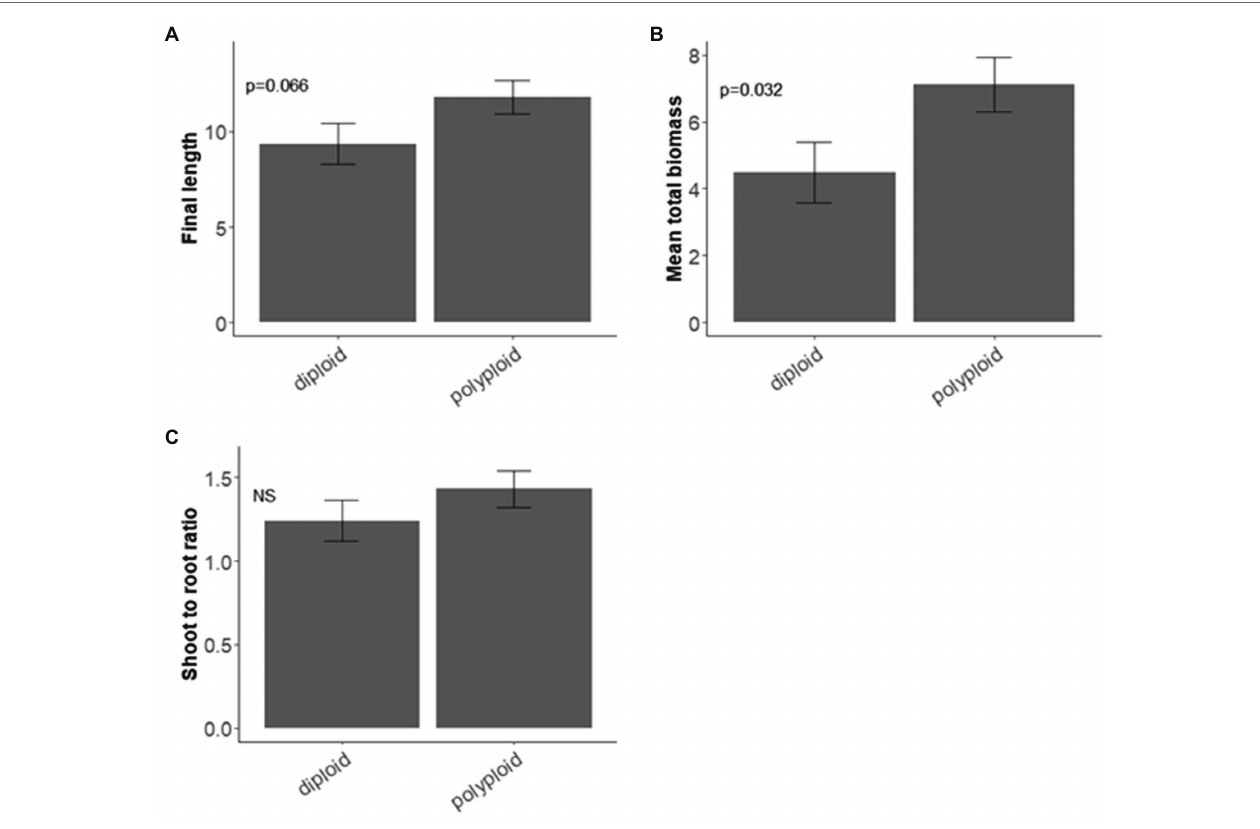
FIGURE 2 | Ploidy and seedling traits of Pomaderris . Mean and standard error for (A) stem length (mm) at 6 weeks ( n = 25 per species for each treatment), (B) biomass (mg; n = 5 per species for each treatment), (C) biomass shoot to root ratio (SRR; n = 5 per species for each treatment). NS indicates a non-significant